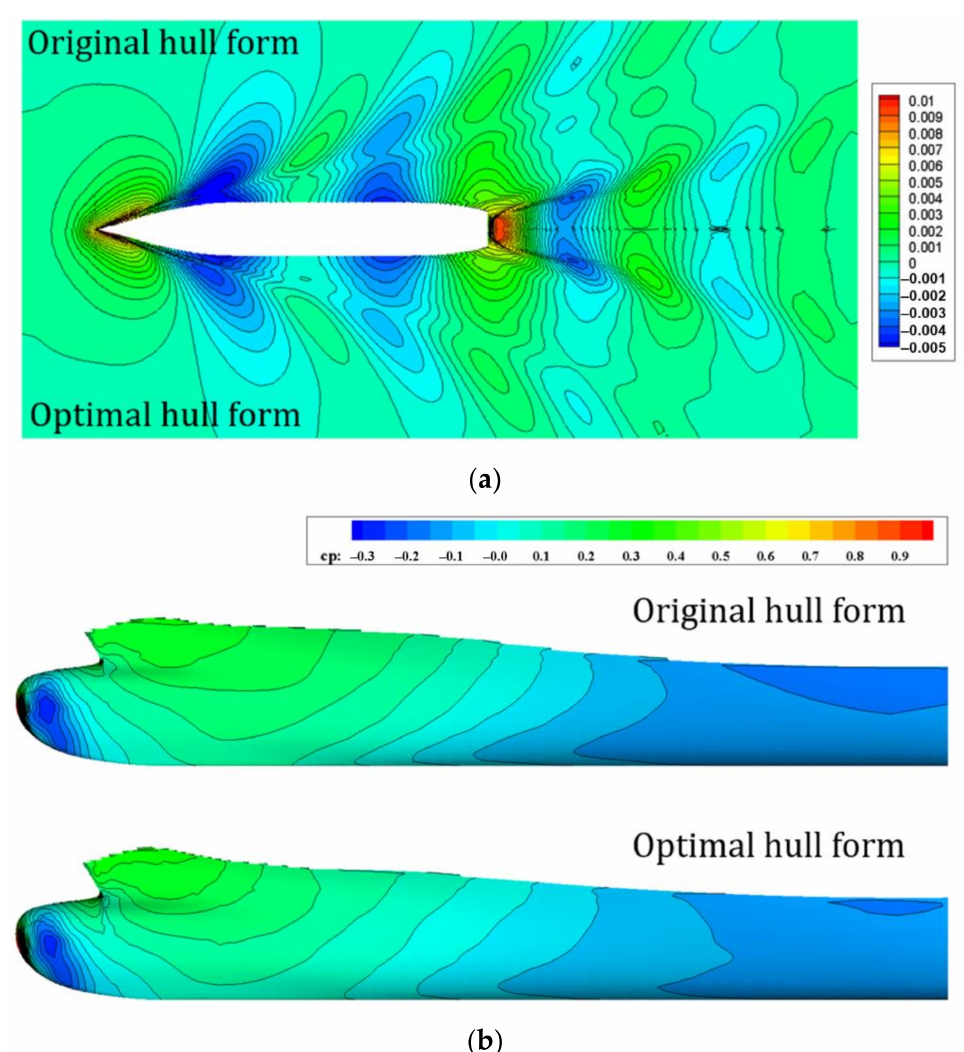
Figure 11. Comparison of the contours of wave elevation and hull pressure distribution. ( a ) Wave elevation; ( b ) Wave